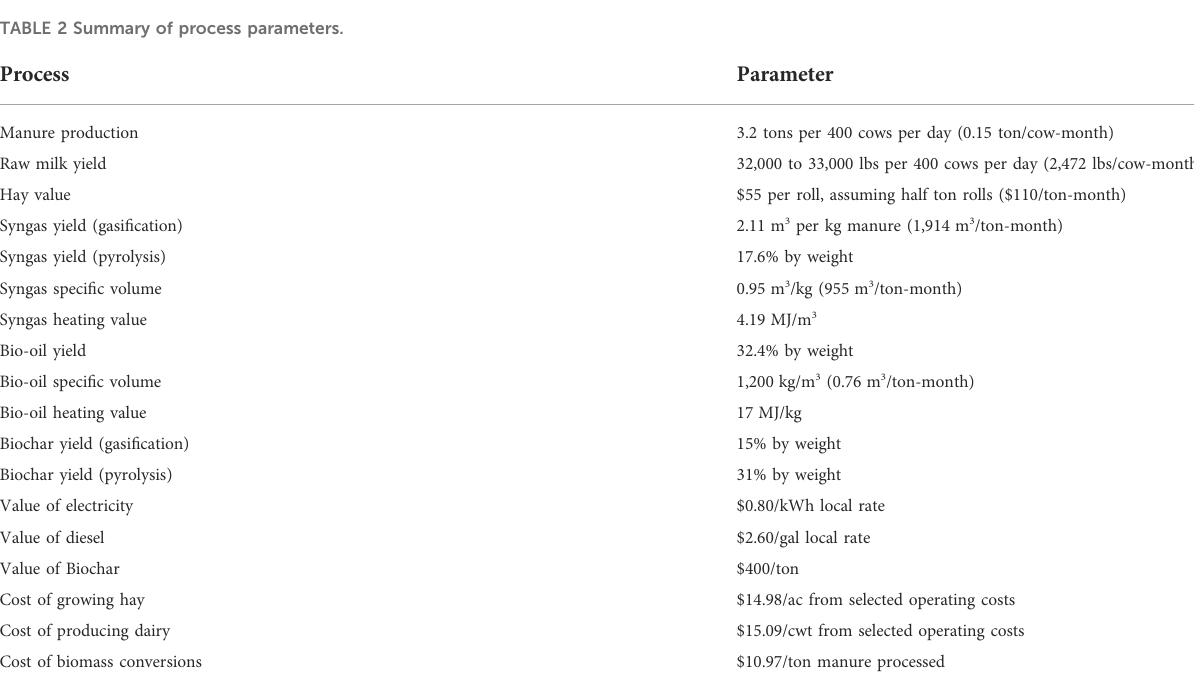
TABLE 2 Summary of process